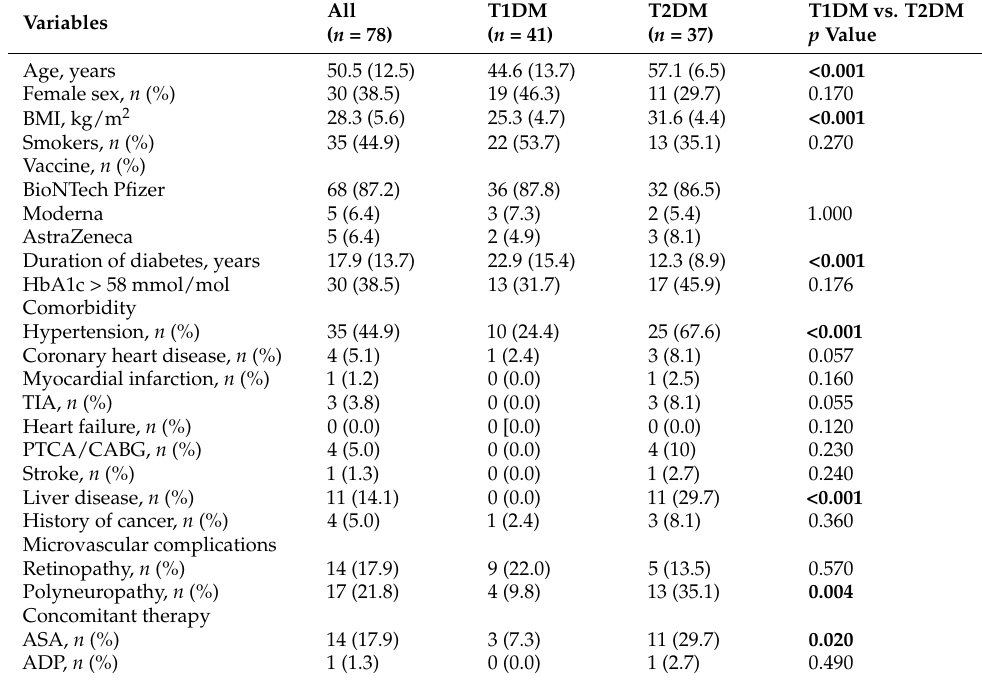
Table 1. Patients’ characteristics. Qualitative variables are presented as frequencies and percent- ages (%). Quantitative variables are presented as means and standard deviations ( ± SD). Fischer’s exact test was applied to compare qualitative variables with diabetes groups. Student’s t test was applied to compare quantitative variables with diabetes groups. Abbreviations: ADP, adenosine diphosphate; ASA, acetylsalicylic acid; CABG, coronary artery bypass graft; BMI, body mass index; HbA1c, glycated haemoglobin; OA, oral anticoagulants; PTCA, percutaneous transluminal coronary angiography; TIA, transient ischemic attack; T1DM, type 1 diabetes; T2DM, type 2 diabetes.